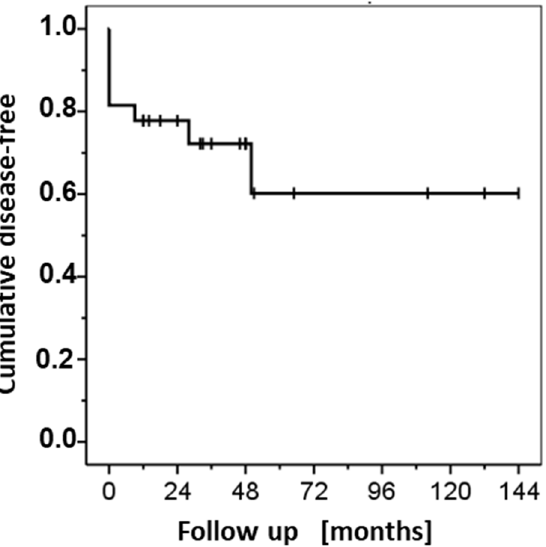
Figure 3. Immunocryosurgery for basal cell carcinoma relapses after surgery. Probability of disease- free tumor site as a function of follow-up time after the first immunocryosurgery treatment cycle (solid line). Short perpendicular bars represent points of censoring events (i.e., times to last available follow-up information of no relapse).